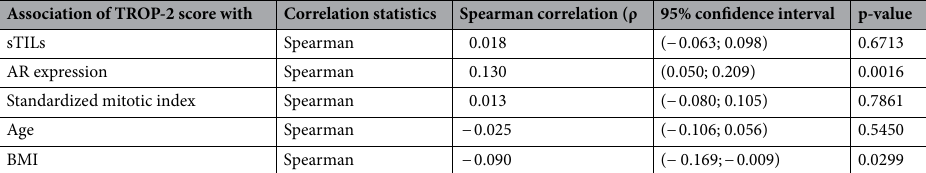
Association of TROP-2 score